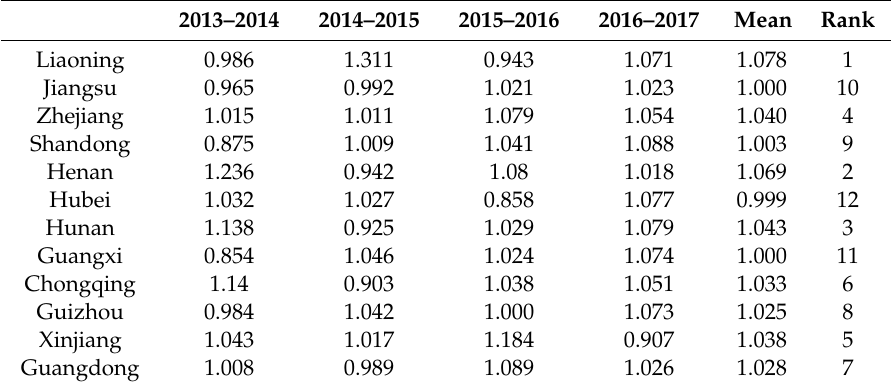
Table 4. Results for the dynamic carbon emissions efficiency index of the logistics industry (DLCEI) for the pilot regions.